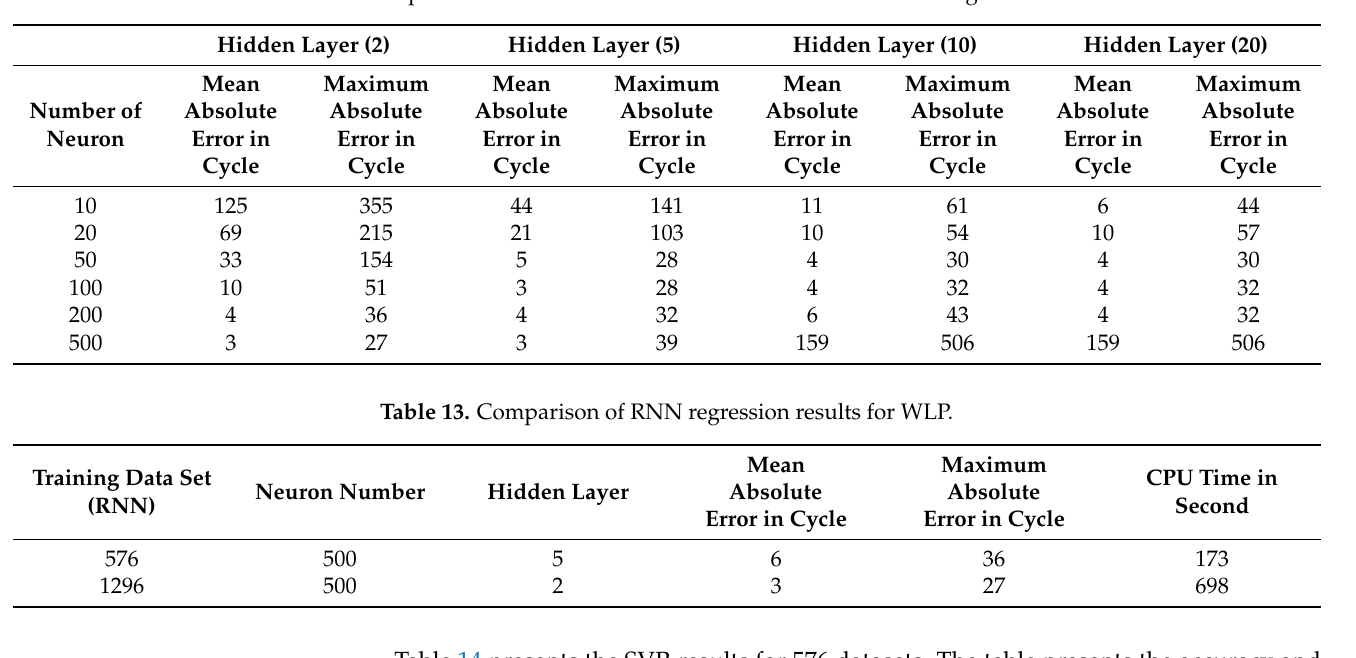
Table 12. Comparison results of FEM and RNN models on 1296 training datasets.